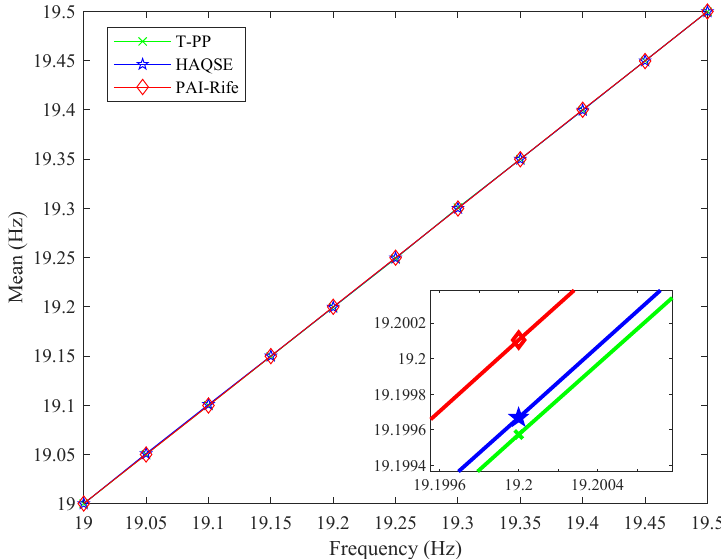
Figure 4. Mean of PAI − Rife and other frequency domain estimation algorithms at different frequencies.